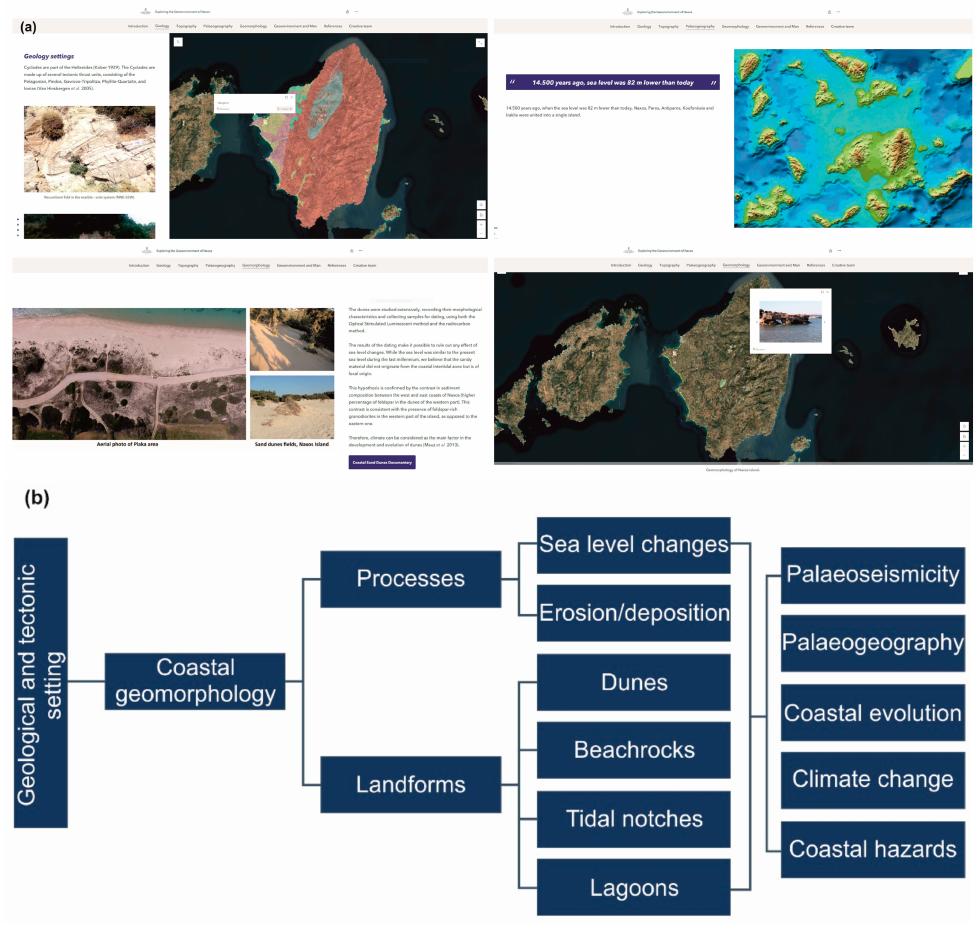
Figure 1. ( a ) Examples of the virtual field trip developed using ArcGIS StoryMaps. ( b ) Flow chart with the main curriculum covered during the virtual field